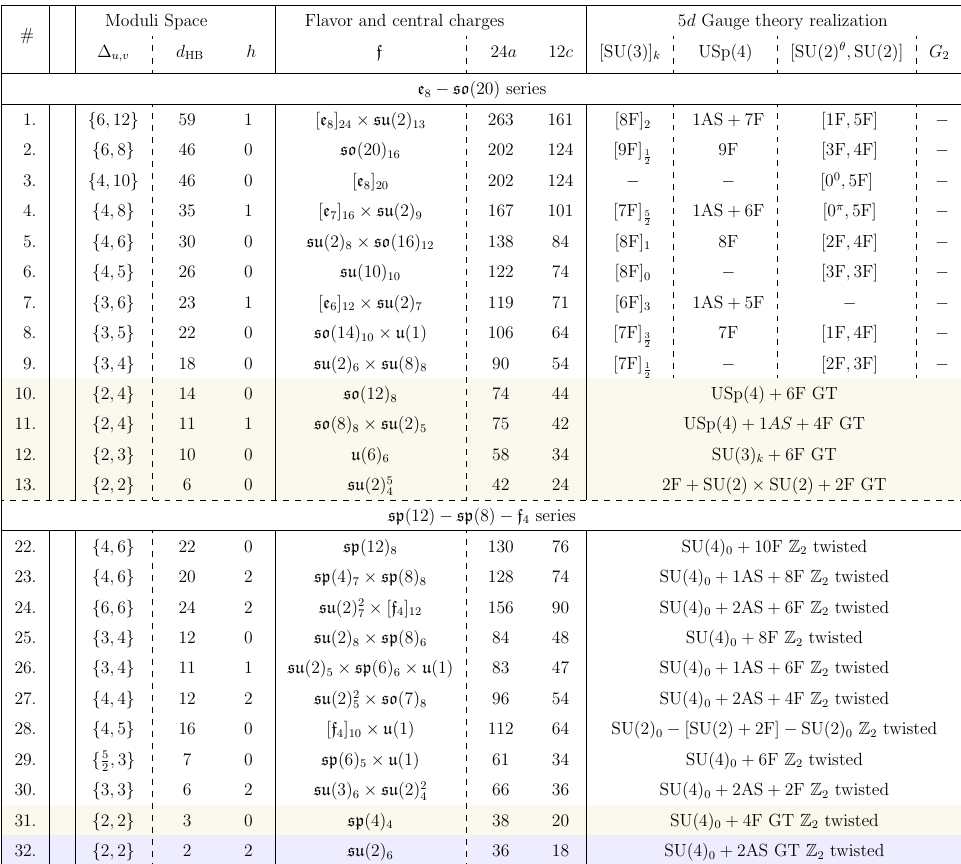
Table of Rank-2 theories I